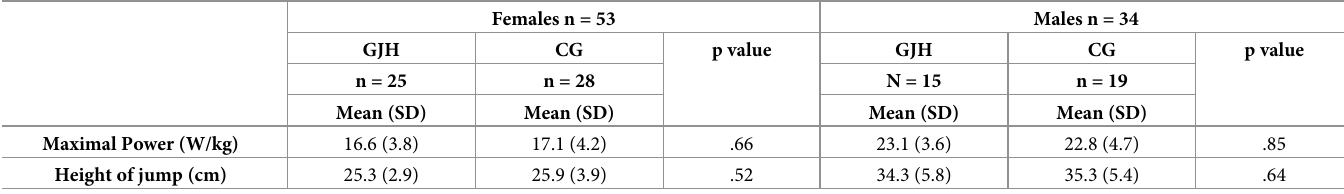
Table 6. The comparison of maximal muscle power and jumping ability obtained by females and males with and without generalized joint